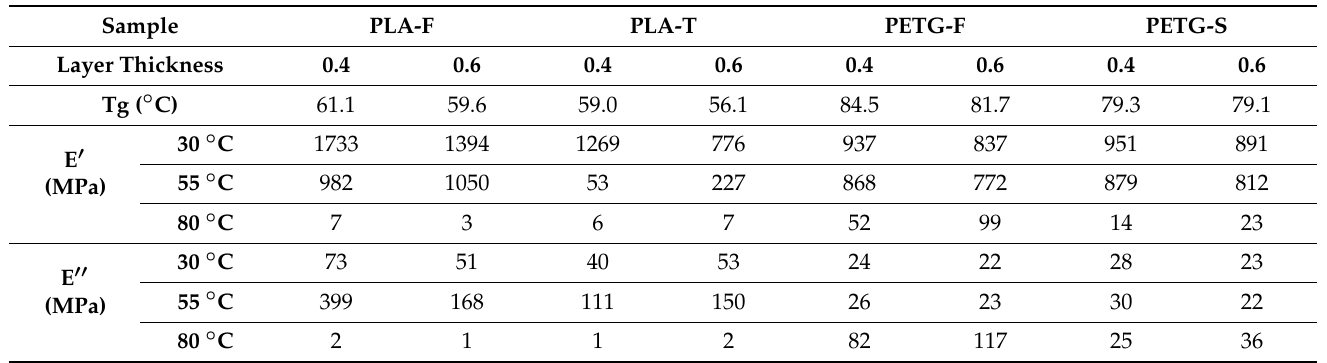
Table 3. DMTA results of the considered polymer samples.